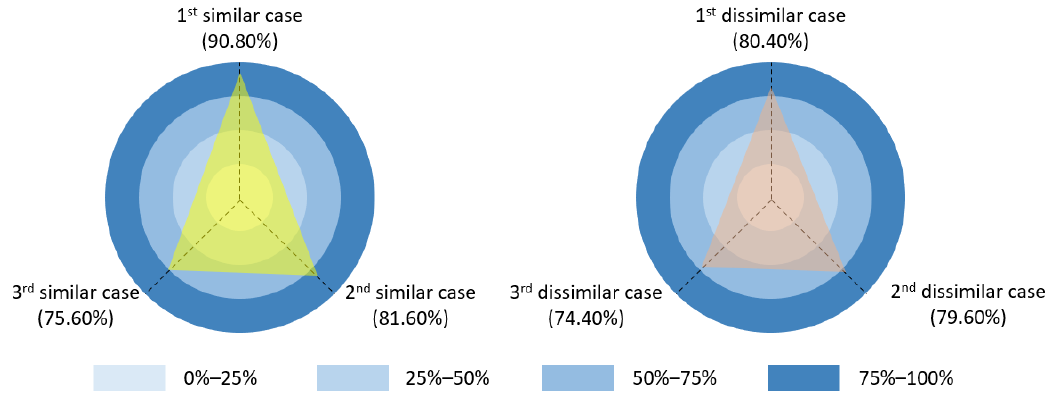
Figure 12. The average precision of retrieved top three similar and dissimilar past cases (new cases are retained).